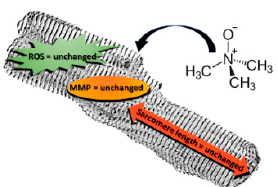
Figure 7. No effects of TMAO are detectable on isolated adult rat cardiomyocyte viability, sarcomere length, ROS production, and mitochondrial membrane potential.